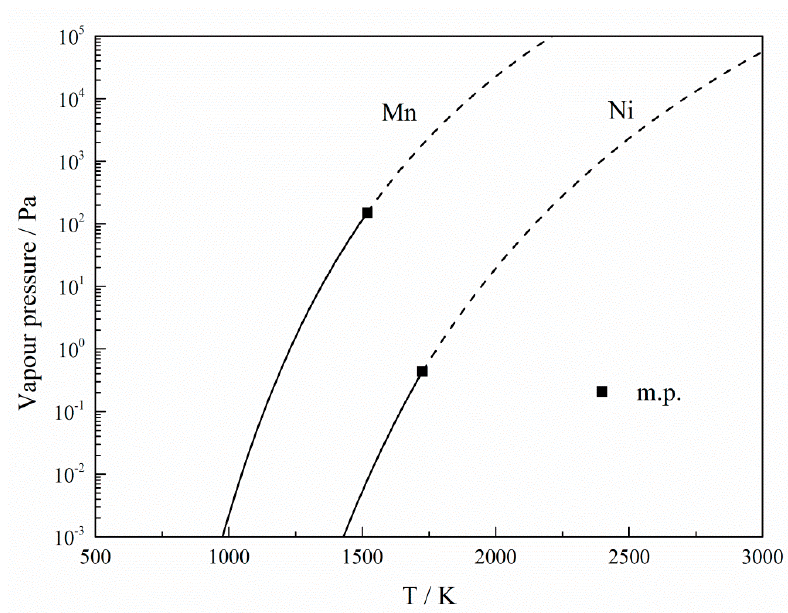
Figure 7 Vapor pressures of manganese impurity and nickel metal as a function of temperature. Figure 7. Vapor pressures of manganese impurity and nickel metal as a function of